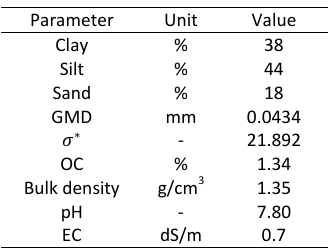
Table 1: Some physical and chemical Table 1. Some physical and chemical characteristics of characteristics of the studied soil the studied soil